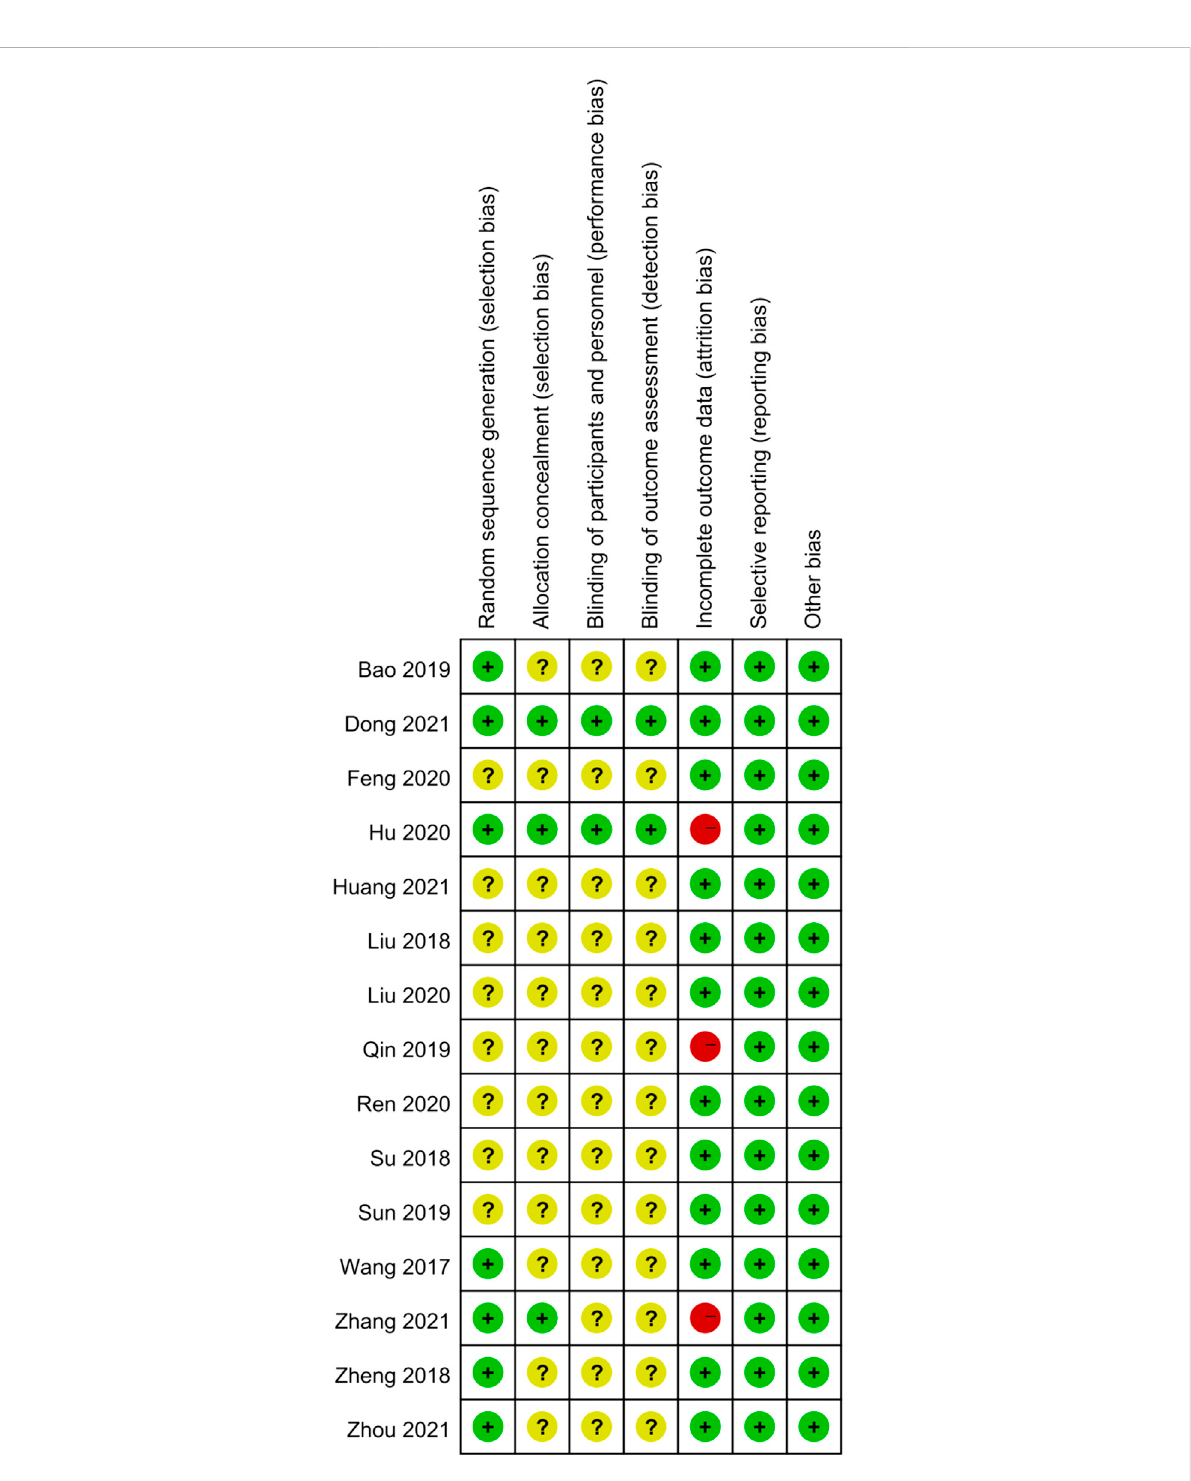
FIGURE 3 Risk of bias summary. The judgments of the reviewing authors about each domain of bias for each included study were